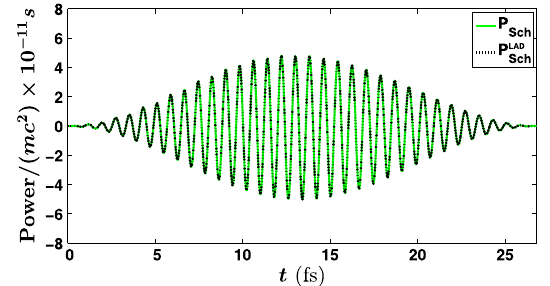
ð t Þ and P LAD ð t Þ for the sinusoidal- FIG. 9. Comparison of P Sch Sch envelope linearly polarized plane wave with parameters given in Fig.